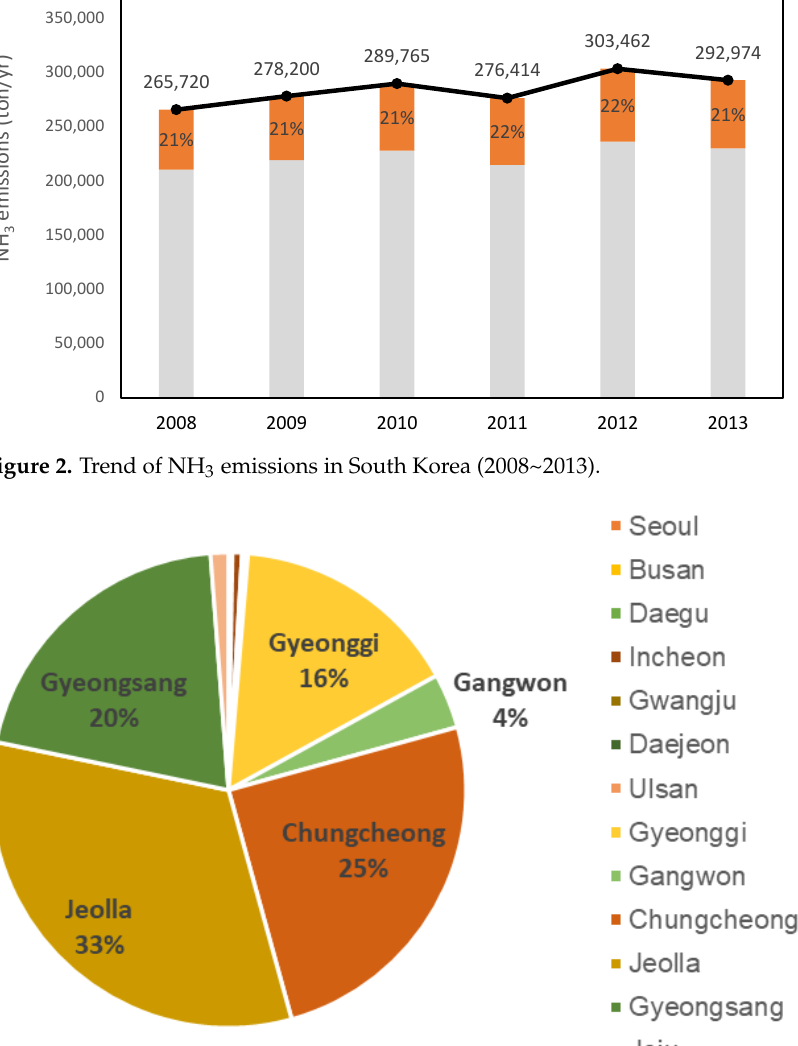
Figure 2. Trend of NH 3 emissions in South Korea (2008~2013) .